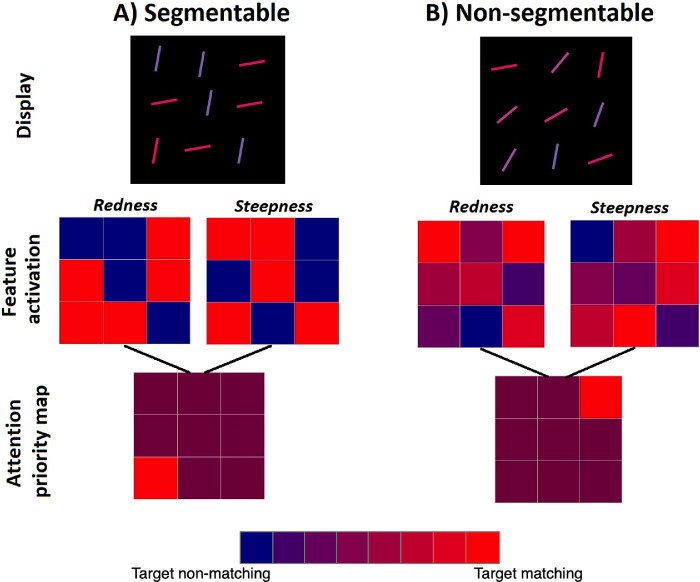
A Guided search (Wolfe, 1994; Wolfe et al., 1989) account for the absence of the effect of segmentability on conjunction search in Experiments 1 and 2. The proposed mechanism is based on the parallel use of top-down activation patterns from color (“redness”) and orientation (“steepness”) feature map. In (A), highly segmentable colors and orientations both provide distinct patterns of strongly activated and weakly activated locations, and their overlap leads to an attentional priority map with many moderately activated locations and one highly activated location corresponding to the target. In (B), non-segmentable colors and orientations both provide fuzzy patterns of top-down activation, but their overlap looks similar to the pattern in (A). Colors on Feature activation maps represent hypothetical top-down activation weighted by the similarity of a feature at a given location with the target feature. Each location on the Attention priority map is colored as the average of activation values in corresponding locations of the two Feature activation maps.